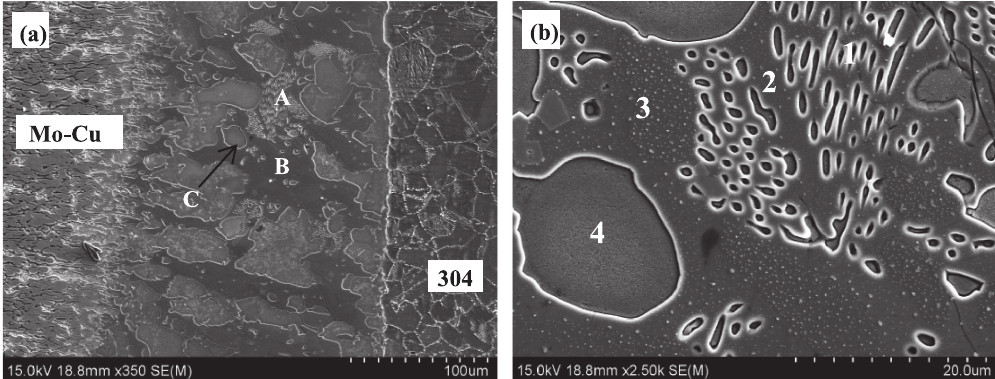
Fig. 2: Microstructure characteristics of Mo-Cu/304 stainless steel joint: (a) bonding joint, (b) braze